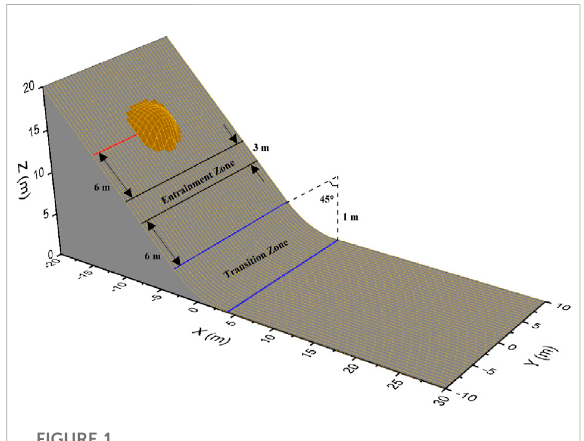
FIGURE 1 Schematic diagram of the fl ow of a dry granular material over a simple 3D